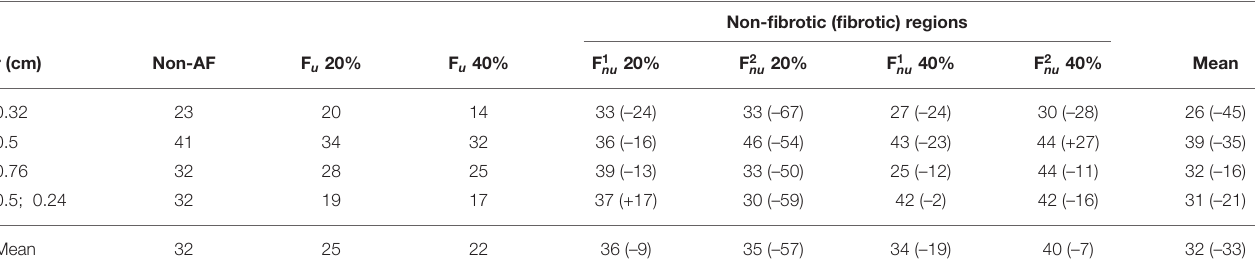
TABLE 3 | Value of the threshold R th expressed as percentage of R A , max .